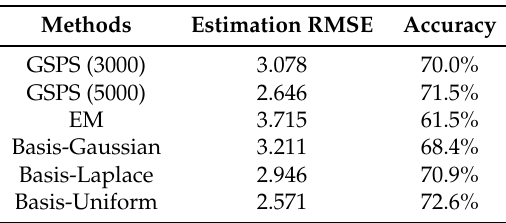
Table 5. Performance comparison of occupancy prediction